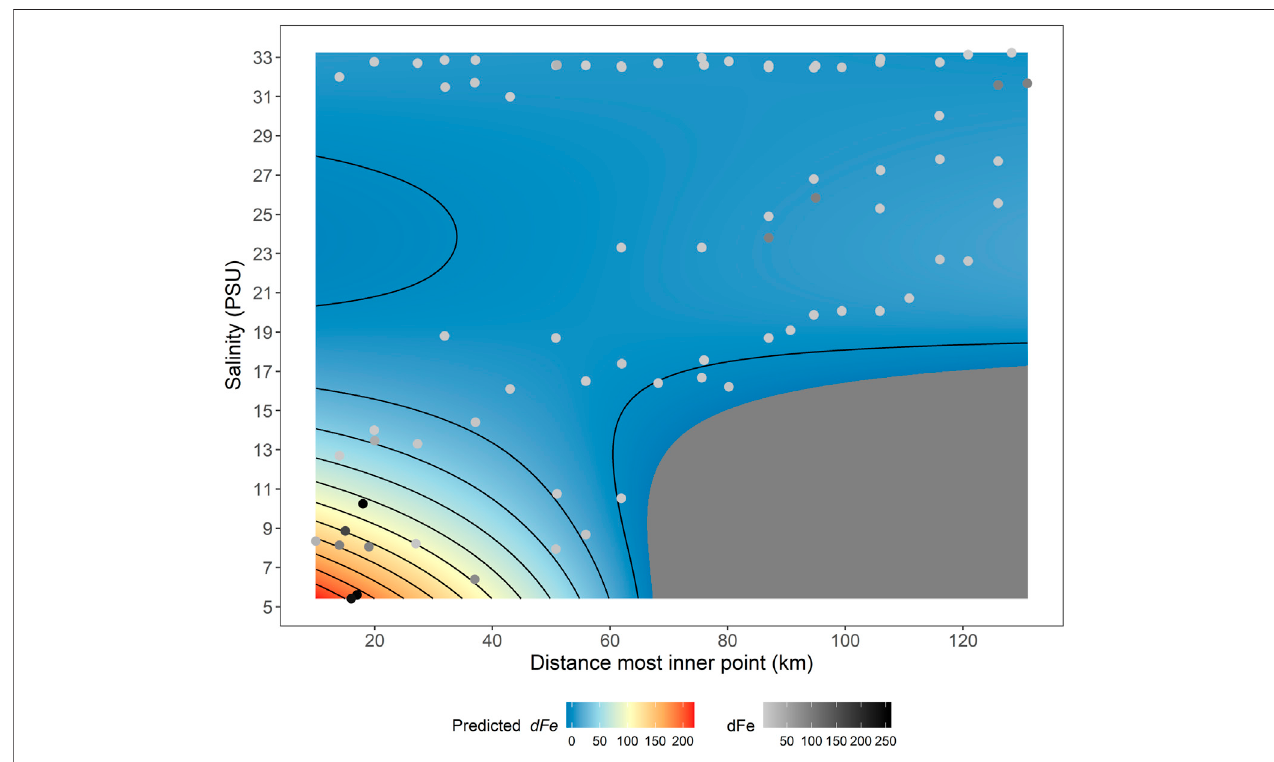
FIGURE6 | AGAM fi tted tothe concentrationof dFe in NuupKangerluaduring May 2014,August 2014,May 2019,August 2019and September2019. Individual points represent the data used to generate the model. The GAM model fi tting process (assessed by AIC and R 2 ) is shown in Supplementary Table S5 .